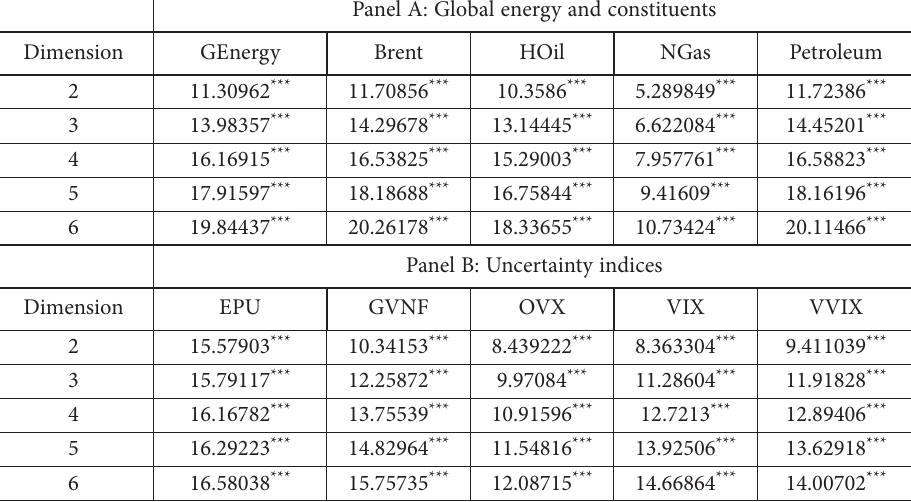
Table 2. Z-statistics from BDS test of linearity Panel A: Global energy and